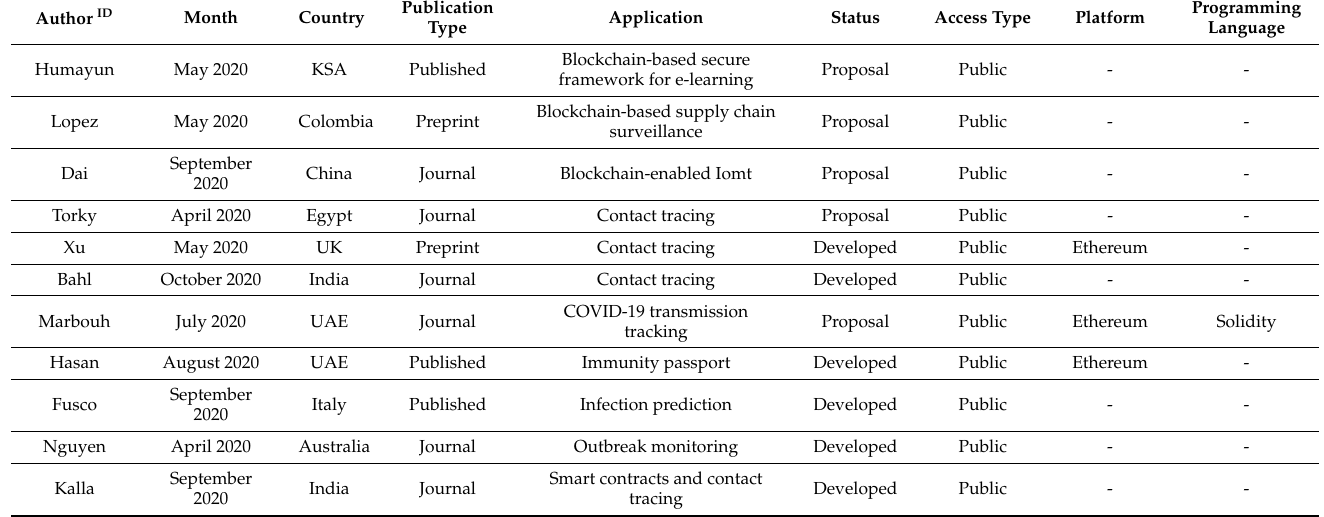
Table A3. Authors and blockchain